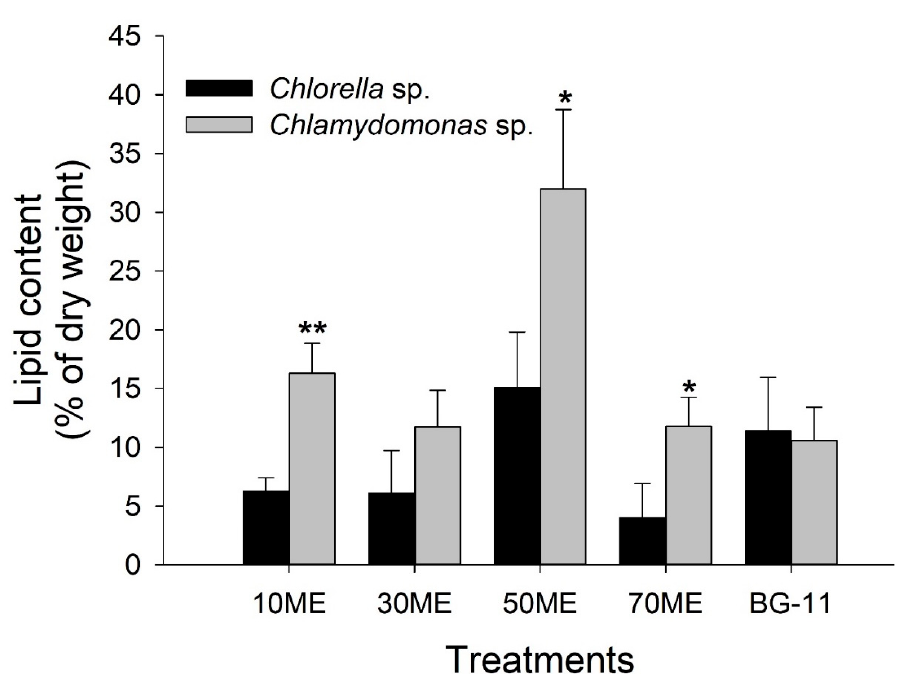
Figure 9. Percentage of lipid content of microalgae species grown in different dilution concentrations of malting effluent. The bars (black bars: Chlorella sp. and grey bars: Chlamydomonas sp.) represent mean lipid content and errors refer to standard deviation. The level of significance is from two-sample t -test statistics (* p < 0.05, ** p < 0.01).